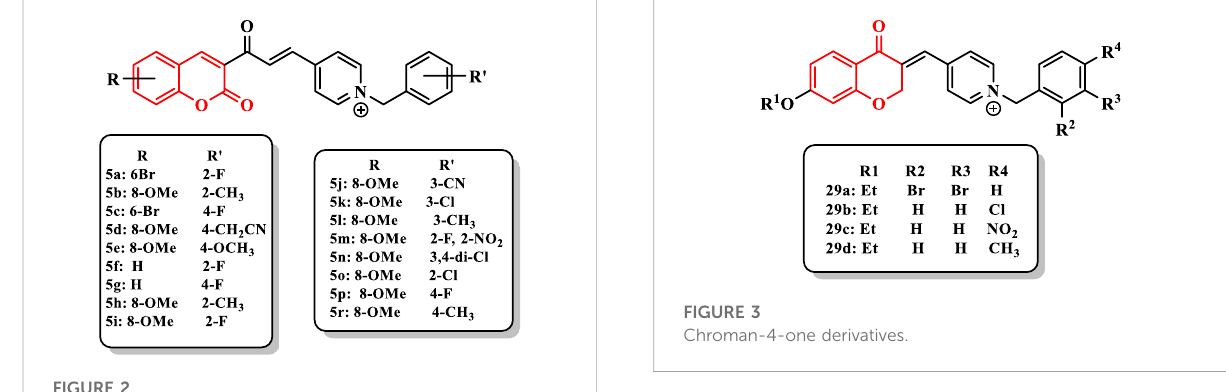
FIGURE 2 Coumarin derivatives bearing N -benzylpyridinium moiety.